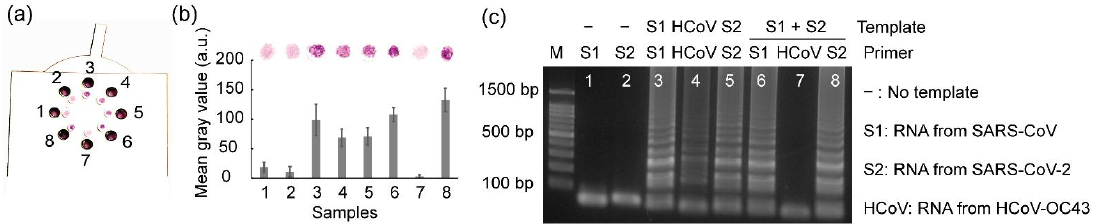
Figure 8. Results showing ( a ) multiplex detection using the rotatable paper device, ( b ) mean gray analysis, and ( c ) agarose gel electrophoresis. Lanes 1 and 2 show the negative controls. Lanes 3–5 show positive controls. Lanes 6–8 show multiplex detection. All the experiments were repeated three times.